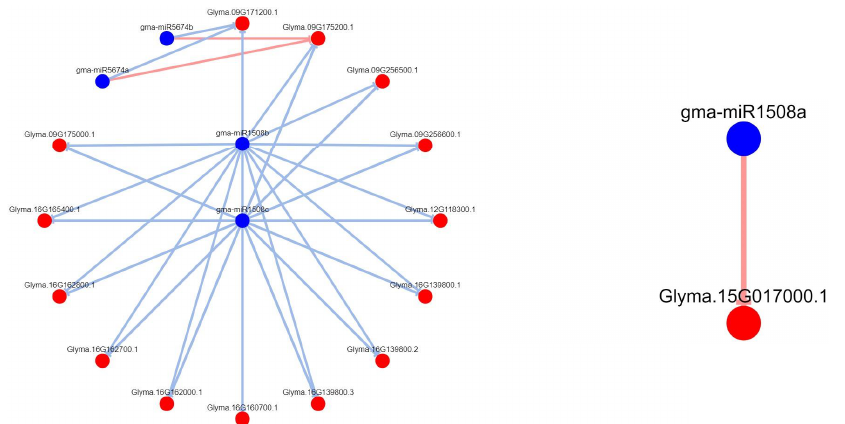
Figure 9 Degradome-based gma-miR1508a/b/c-target interaction and network. Note: using the DPMIND Figure 8. Degradome-based gma-miR1508a/b/c–target interactions and network. Note: we used software (http://cbi.njau.edu.cn/DPMIND/network.php?race_id=3847) to obtain the network. DPMIND software (http://cbi.njau.edu.cn/DPMIND/network.php?race_id=3847, 1 January 2022) to obtain the network. Note: blue circles indicate miRNA, red circles indicate targets, red lines indicate strong evidence, blue lines indicate weak evidence.